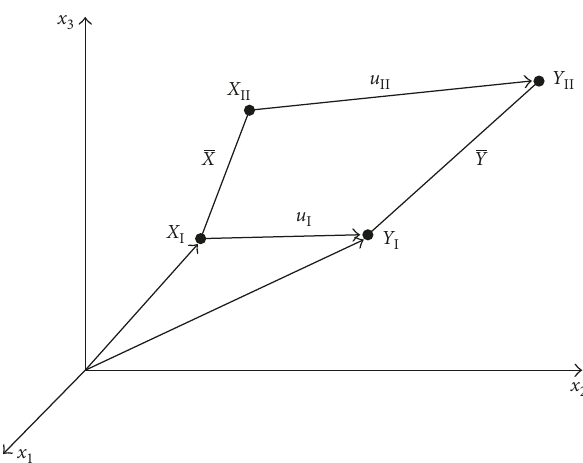
Figure 3: A single bond in the reference and the current